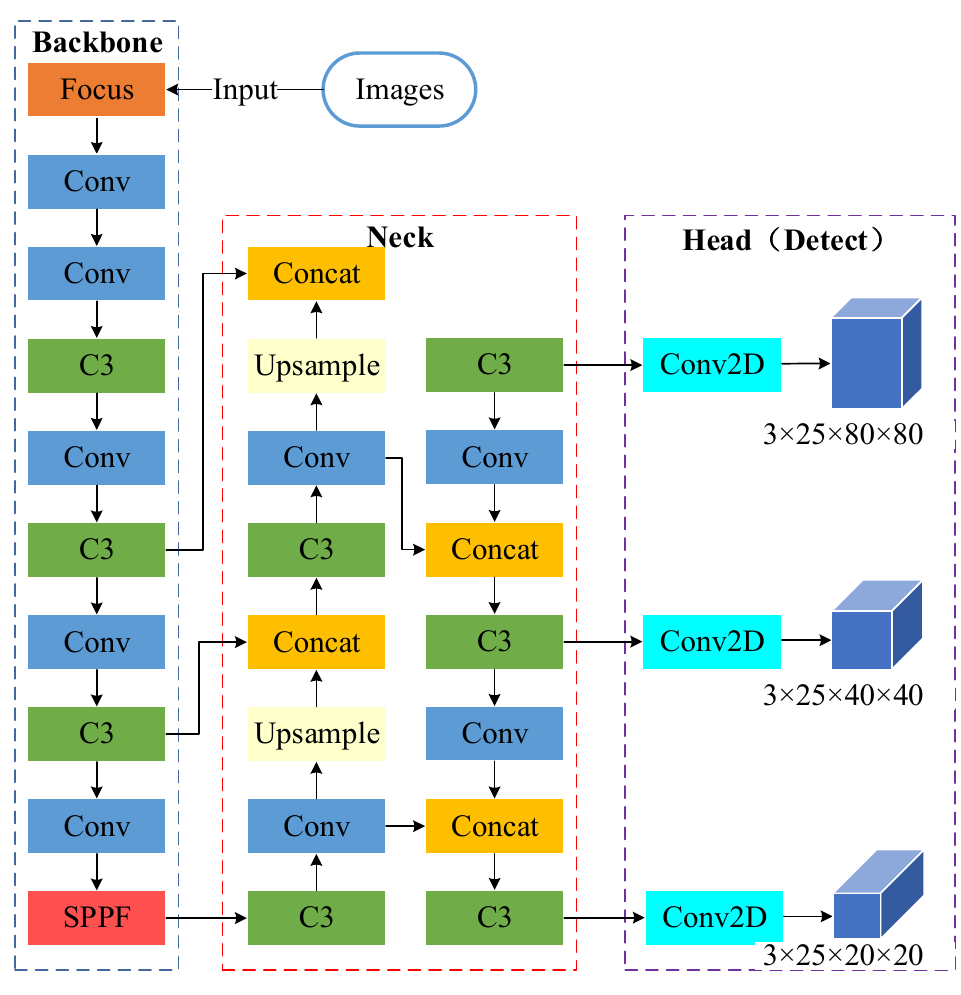
Figure 7. The architecture of YOLOv5 network.